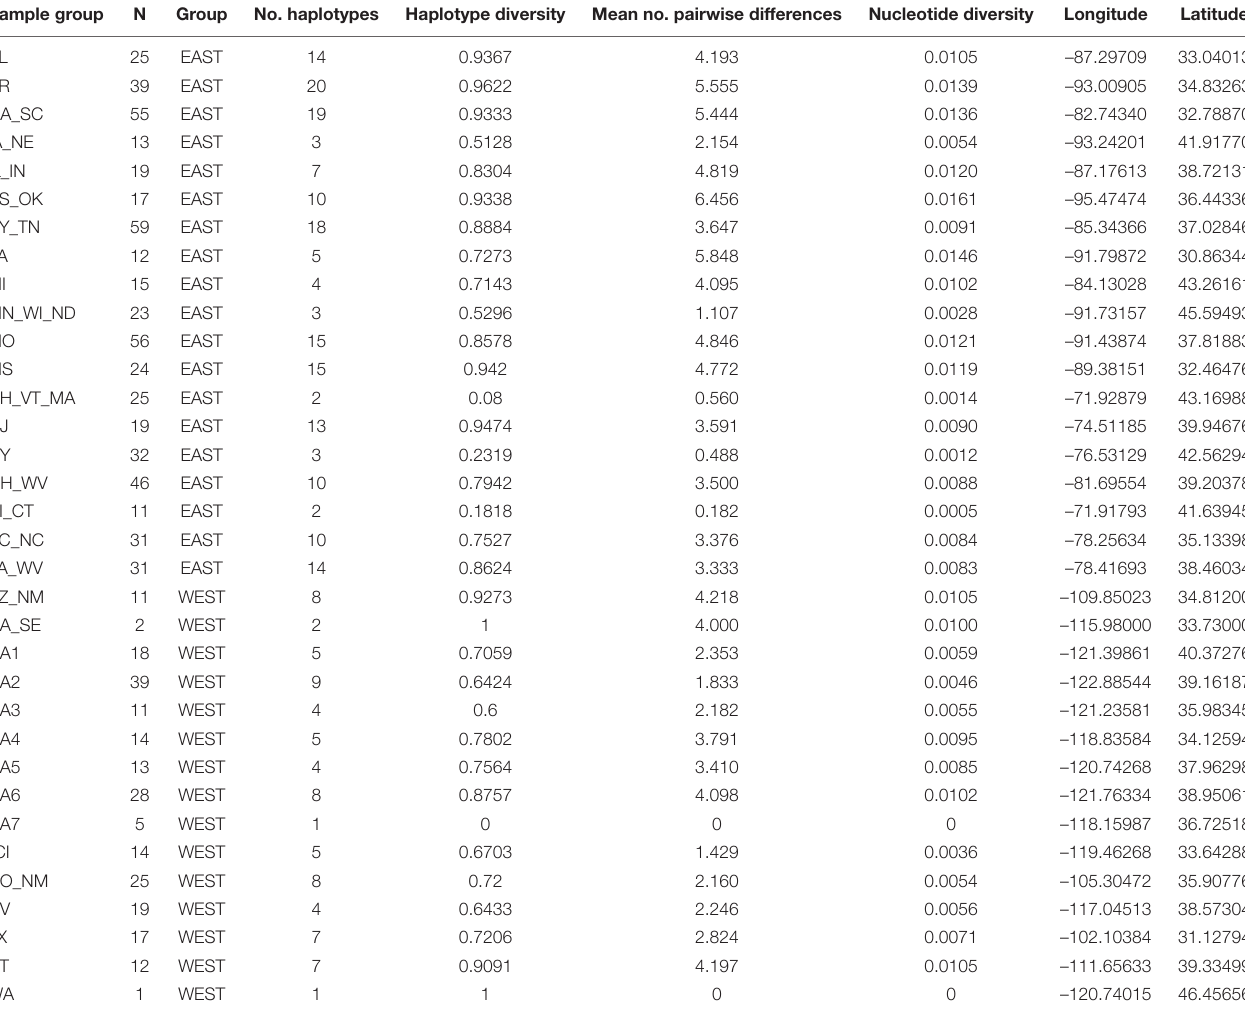
TABLE 1 | Information and indicators of molecular diversity (400 bp mtDNA control region) for gray fox ( Urocyon cinereoargenteus ) sample groups, except *CI = Urocyon littoralis. Sample